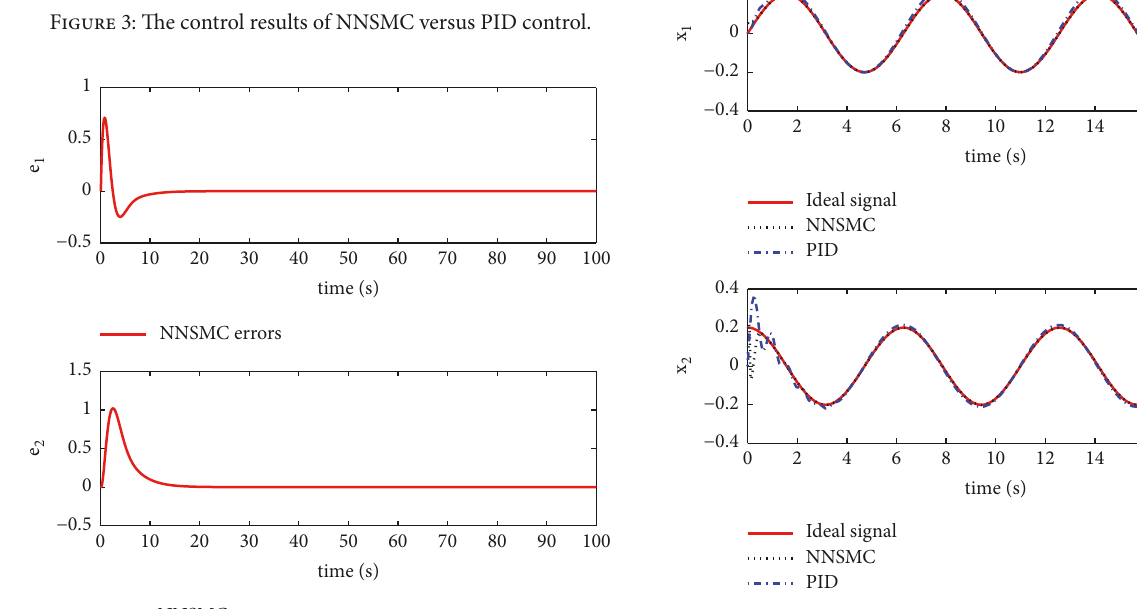
Figure 6: The control results of NNSMC versus PID